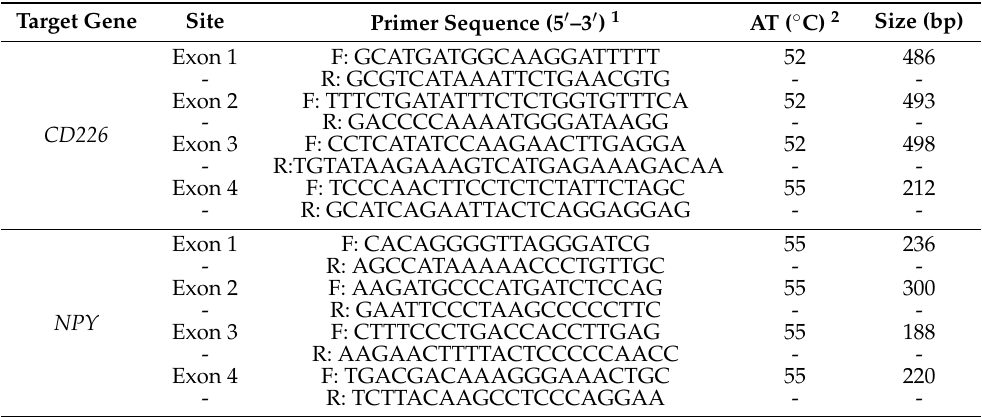
Table 1. Primer sequences, amplified exon (site), annealing temperatures (AT), and amplification fragment